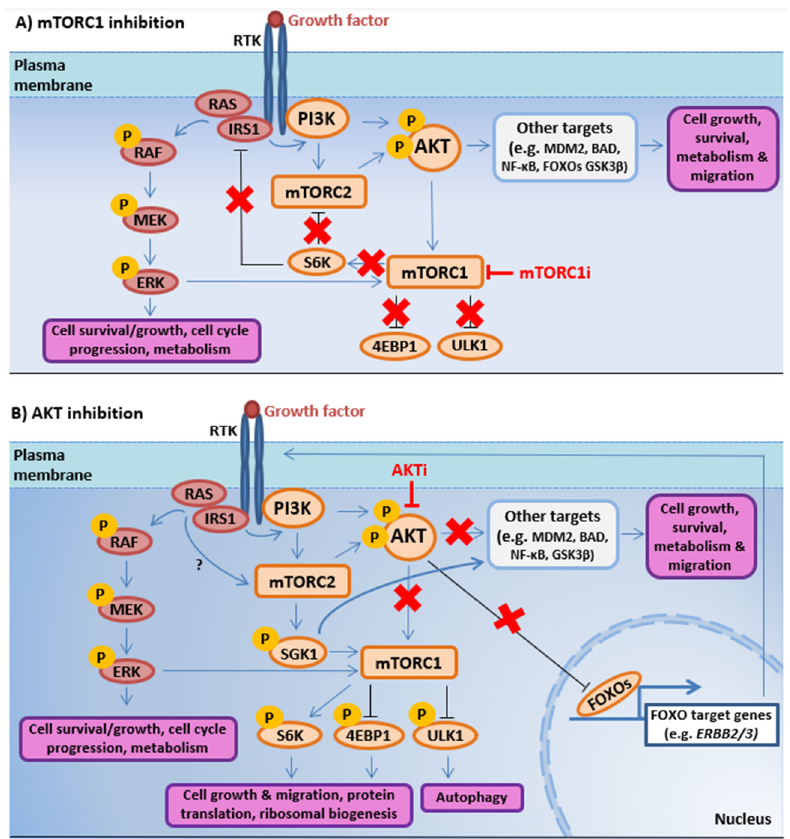
Figure 2. PI3K-AKT-mTOR and RAS/MAPK pathway crosstalk can contribute to mTORC1 and AKT inhibitor resistance. Model schematics illustrating reported mechanisms of therapeutic resistance to ( A ) mTORC1 inhibition and ( B ) AKT inhibition. mTORC1 and AKT blockade potentiates a series of feedback/feedforward loops between the PI3K-AKT-mTOR and RAS/MAPK signaling pathways, leading to augmented RAS/MAPK signaling and incomplete suppression of the PI3K-AKT-mTOR cascade that can promote drug-resistant tumor growth. AKTi, AKT inhibitor; mTORC1i, mTORC1 inhibitor.